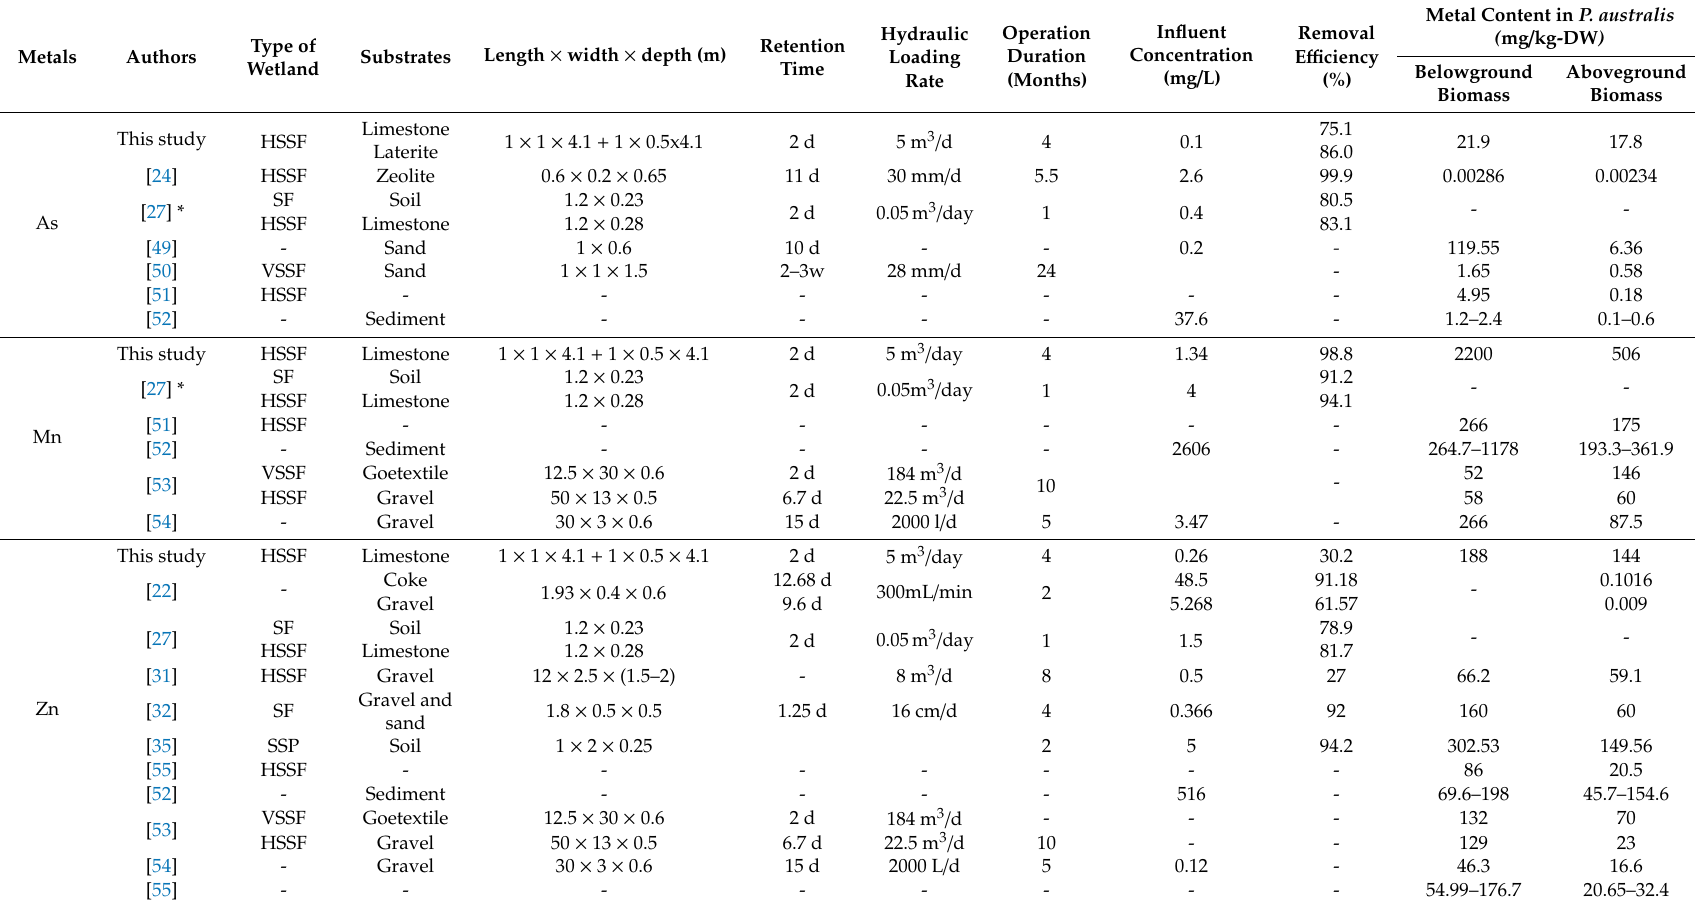
Table 4. Constructed wetland designs, removal e ffi ciencies, and concentrations of As and heavy metals in P.